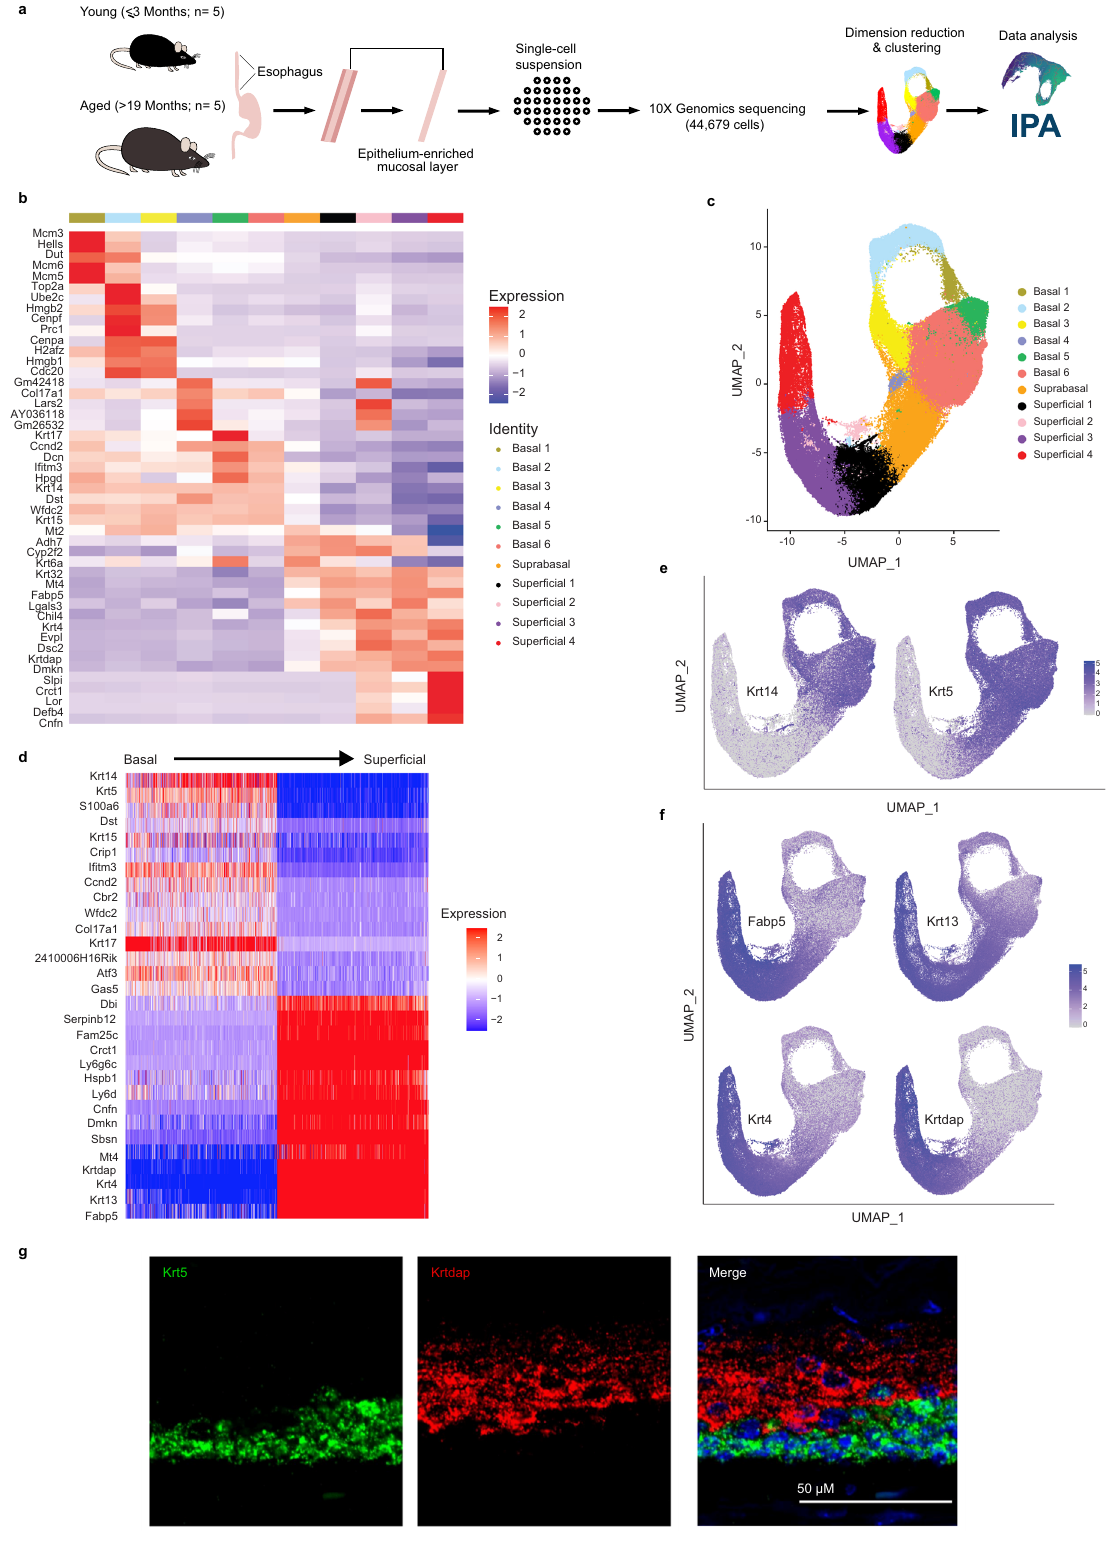
response to high calcium (0.6 mM) in vitro (Fig. 2d). Immuno- blotting analysis revealed that EIF2 α , EIF2B ε , RPL10, and RPS3 (associated with EIF2 signaling) are more abundant in murine esophageal keratinocytes cultured in 0.018 mM calcium